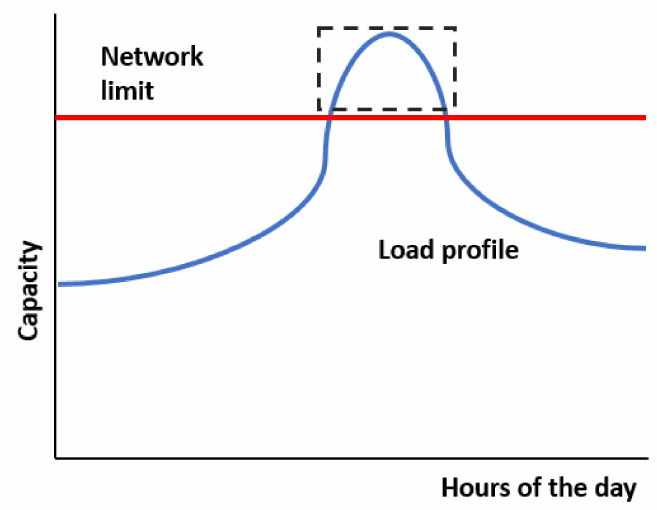
Figure 1. Congestion